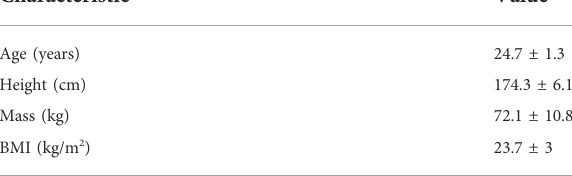
TABLE 1 General information of subjects ( n =